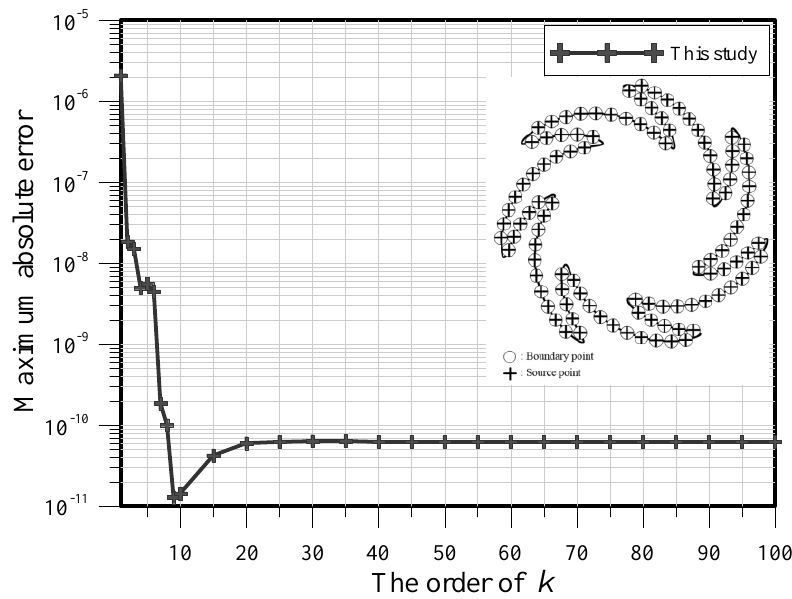
Figure 3. Maximum absolute error (MAE) versus the order of k .